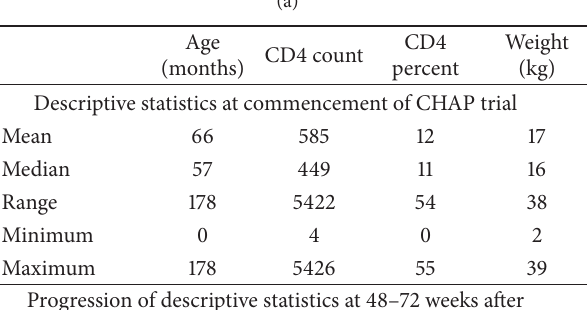
Figure 3: Cost distribution for the cotrimoxazole